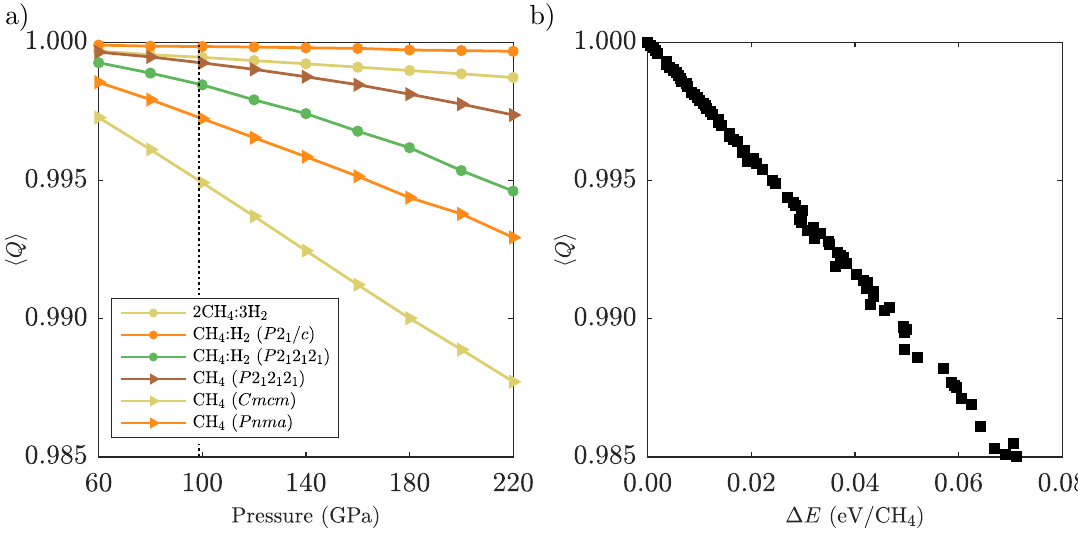
Figure A3. ( a ): Tetrahedrality (cid:104) Q (cid:105) averaged over molecules in the unit cell for structures containing methane. ( b ): Estimated increase in internal energy for the same range of (cid:104) Q (cid:105) .